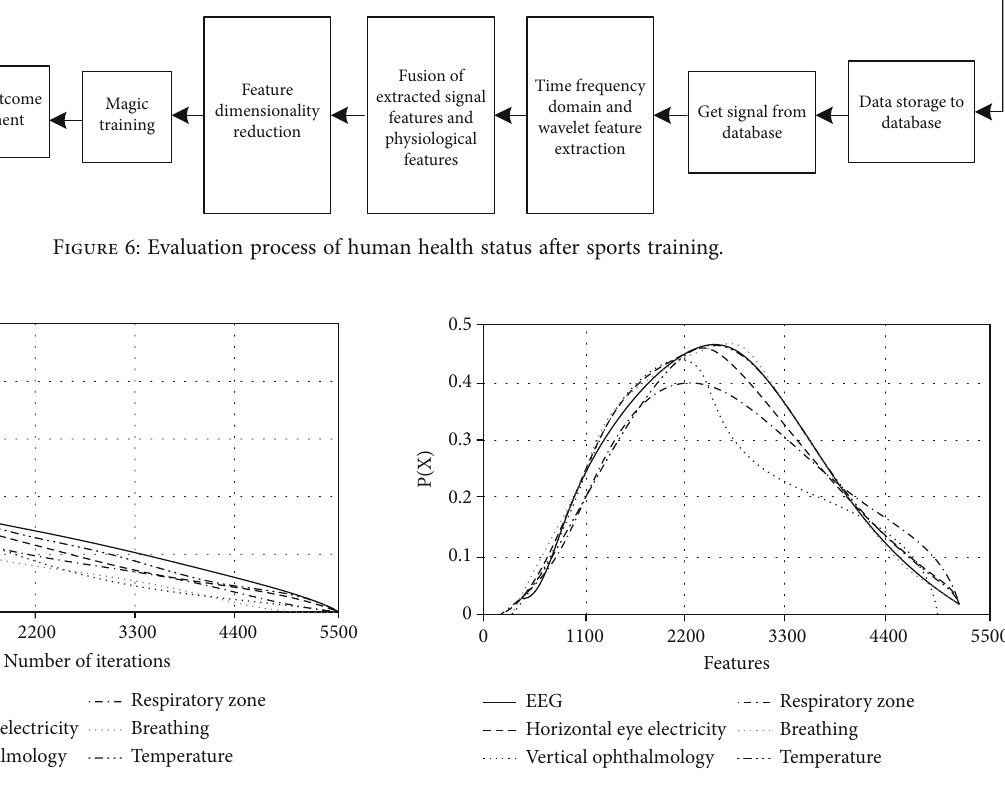
Figure 8: Gaussian distribution of health state change